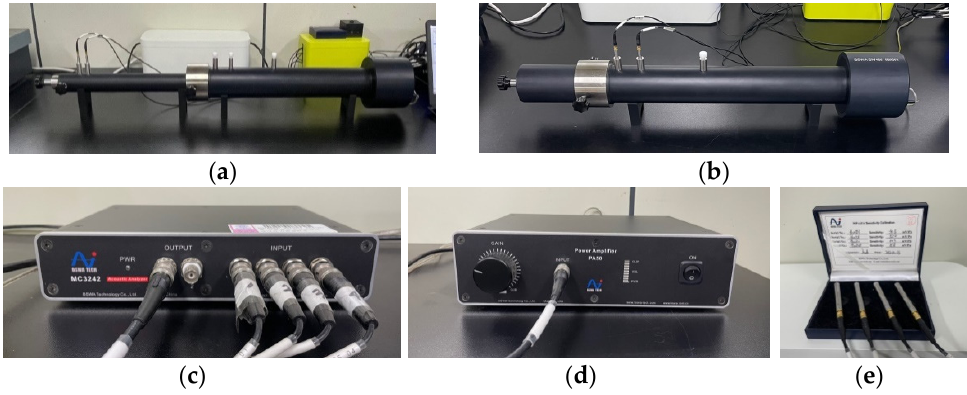
Figure 7. Measuring equipment: ( a ) Impedance tube to measure sound absorption coefficient − 30 mm; ( b ) Impedance tube to measure sound absorption coefficient − 60 mm; ( c ) Acoustic analyzer; ( d ) Power amplifier; ( e ) Microphones.